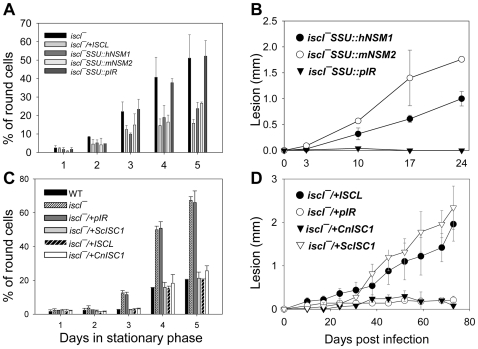
Restoration of stationary phase morphology and acute virulence in iscl− mutants by mammalian neutral SMases and fungal ISC1ps.(A)–(B) Morphology and virulence of iscl− parasites with human neutral SMase 1 (iscl− SSU::hNSM1), murine neutral SMase 2 (iscl− SSU::mNSM2), or pIR1SAT vector only (iscl− SSU::pIR) were examined as described. (C)–(D) Similar experiments were performed using iscl− parasites transfected with pIR1SAT-ScISC1 (iscl−/+ScISC1), pIR1SAT-CnISC1 (iscl−/+CnISC1), and pIR1SAT vector only (iscl−/+pIR). In (A) and (C), promastigotes were grown to stationary phase and the percentage of round cells (day 1 through day 5 in stationary phase) was determined. In (B) and (D), infectivity of stationary phase promastigotes was examined by footpad infection assay using BALB/c mice (2×107 cells/mouse in B and 1×106 cells in D) and the progression of lesions was monitored weekly. Error bars represent standard deviations.